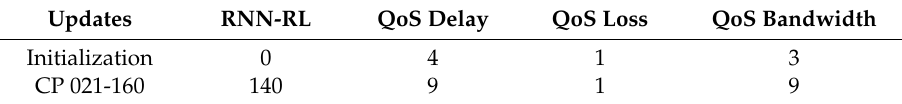
Table 5. Deep Learning Cluster vs RNN-RL (3 × 3